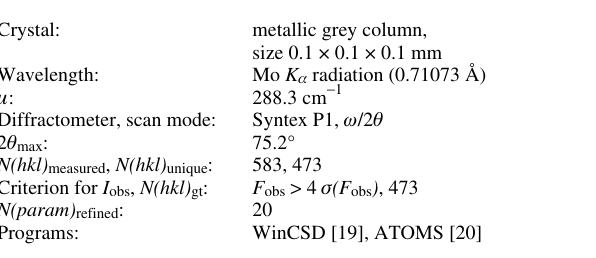
Table 1. Data collection and